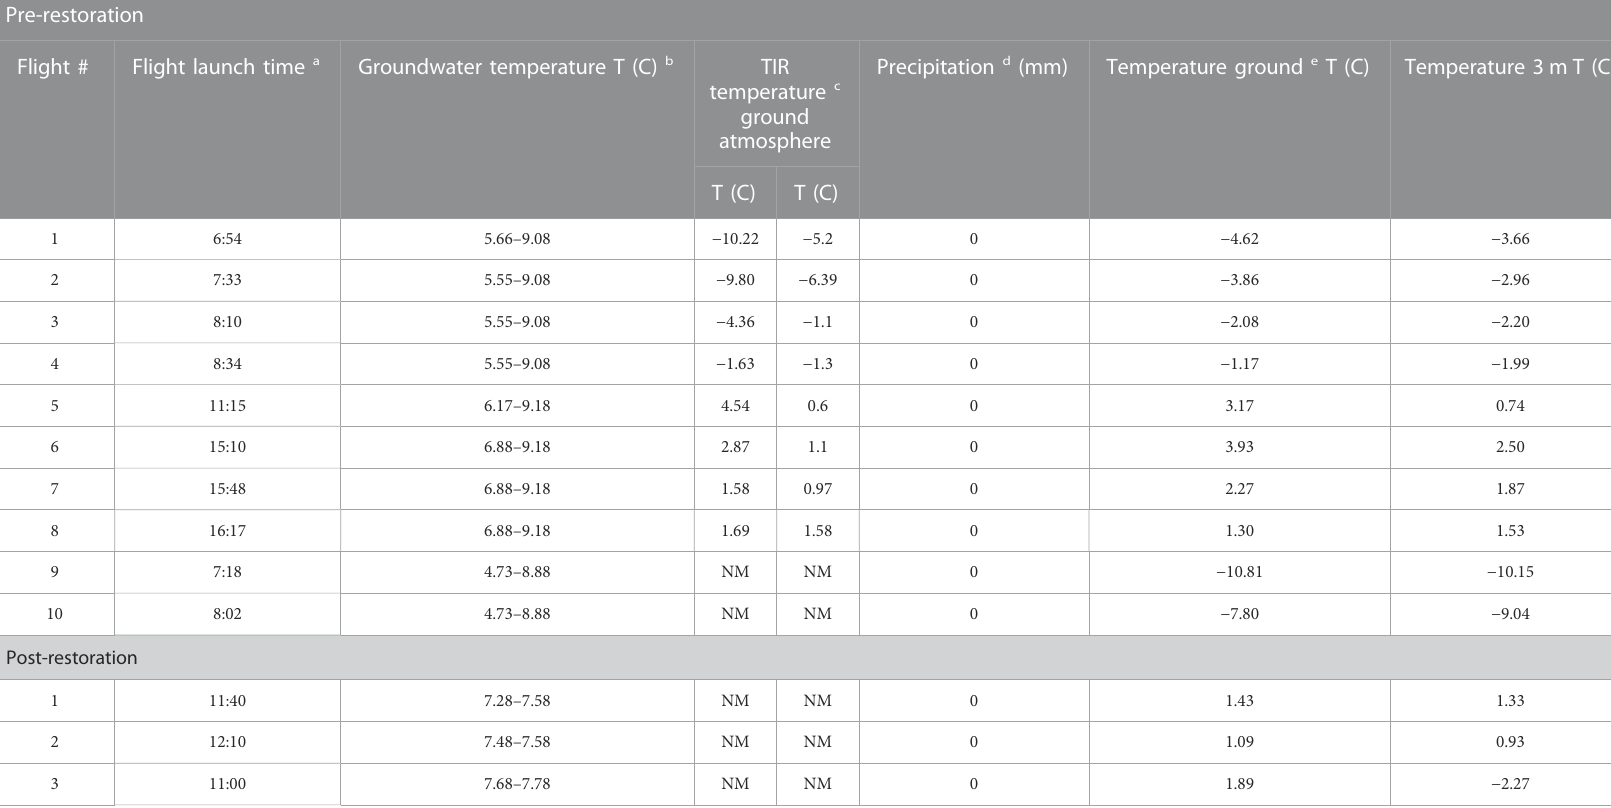
TABLE 1 Atmospheric, site, and groundwater temperature conditions during UAS fl